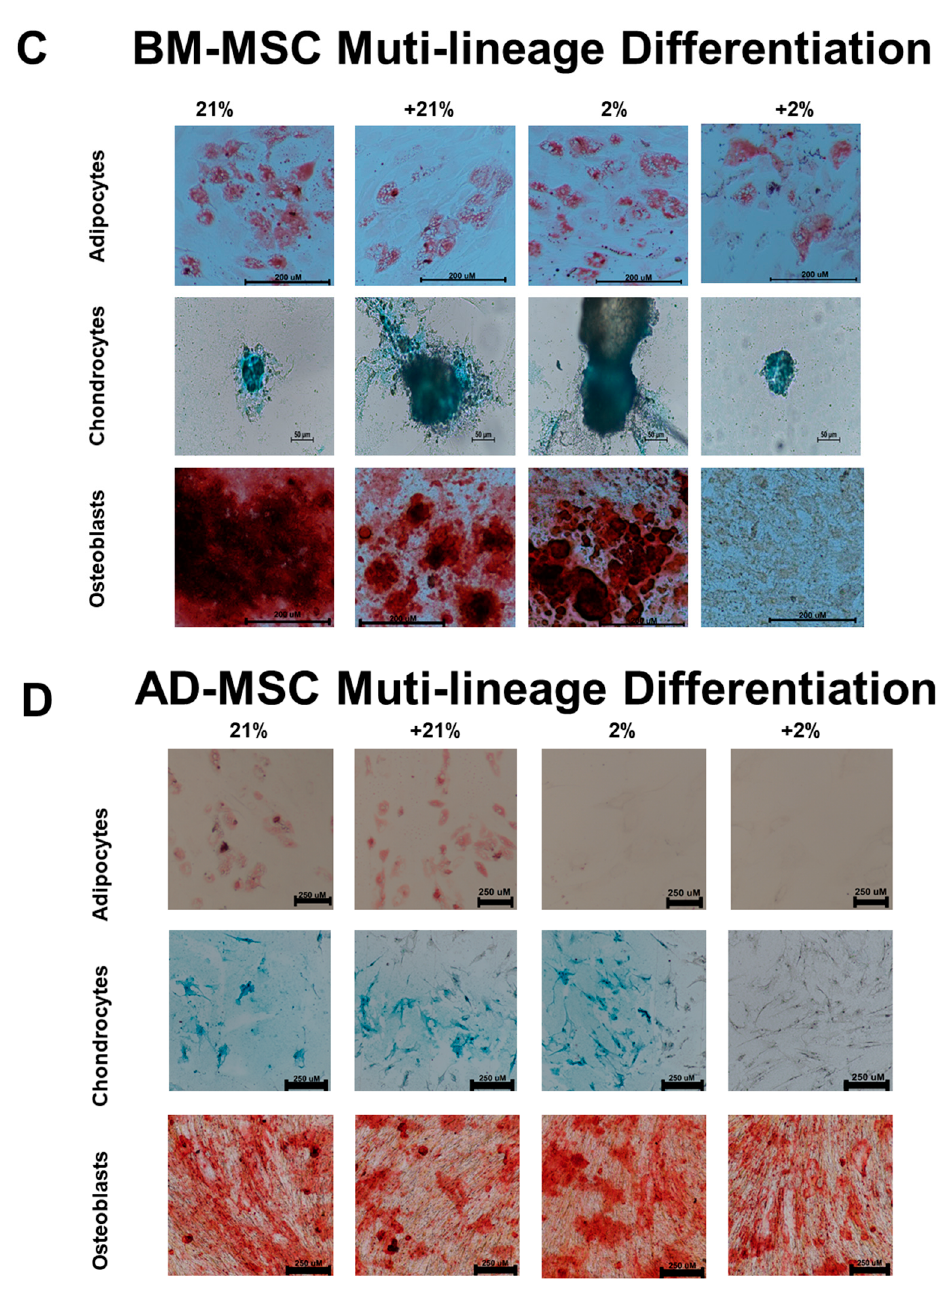
Figure 1. Experimental design, surface marker expression, and tri-lineage differentiation of preconditioned bone marrow (BM) and adipose (AD) derived mesenchymal stromal cells (MSCs). ( A ) MSCs were acclimated for 18 hours after thawing and then incubated under normoxia or hypoxia with or without the addition of Cytomix. Following 48-hour incubation, endpoint analyses were conducted. ( B ) Tissue factor (TF) surface expression was increased in BM-MSCs after Cytomix treatment and in Cytomix-hypoxia-treated AD-MSCs. ( C ) BM-MSCs from the Cytomix-hypoxia group were unable to differentiate down the osteogenic pathway. ( D ) AD-MSCs were unable to differentiate into adipocytes under hypoxia or chondrocytes following the Cytomix-hypoxia treatment. Osteogenesis evaluation was done by alizarin red staining; adipogenesis was performed by oil red O staining; and chondrogenesis was conducted by alcian blue staining.